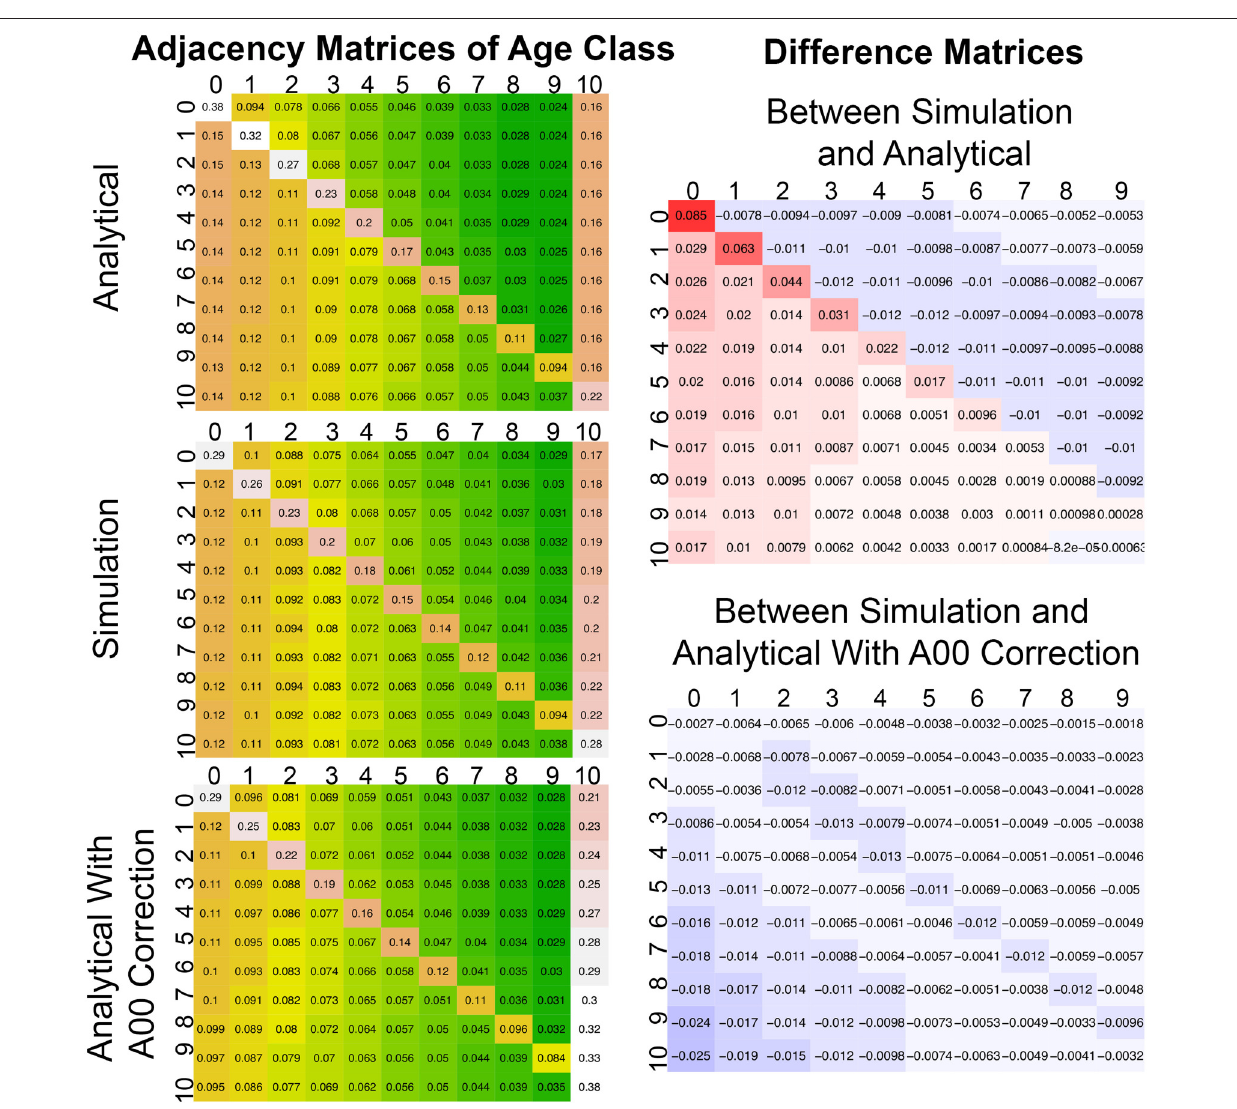
FIGURE 8 | Comparison between adjacency matrices for a stochastic spatial simulation (simulation from Figure 2 , middle) analytical approximation (top), and analytical approximation where a correction was applied to A00. All adjacency matrices are after 1,000 years (steady state). To the right are difference matrices between the simulation matrix and the two analytical matrices. Age class aggregated into 10 year bins ([0 − 9] = 0,[10 − 19] = 1, etc.) with all patches 100 year or older in bin 10. The 10th column of the error matrices was removed because of a summing to 1